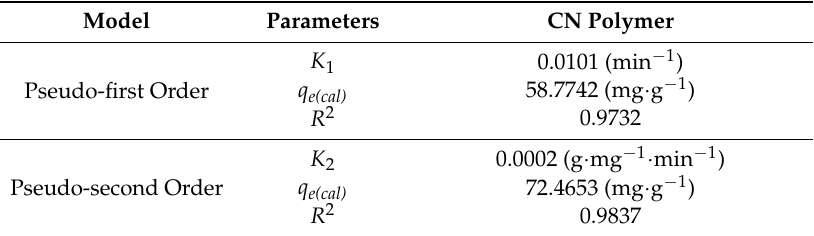
Table 2. Kinetic parameters obtained through the equation of pseudo-first order and pseudo-second order for the drug adsorption by the CN polymer at 298 K, and natural